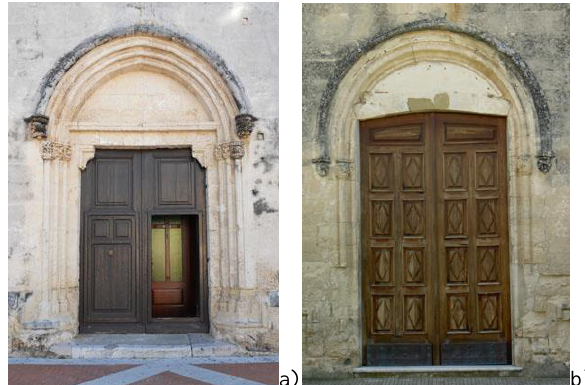
Figure 2. Example of portals: a) pointed arch, San Pietro Assemini, Ca; b) round arch, Beata Vergine Immacolata, Barumini (VS).